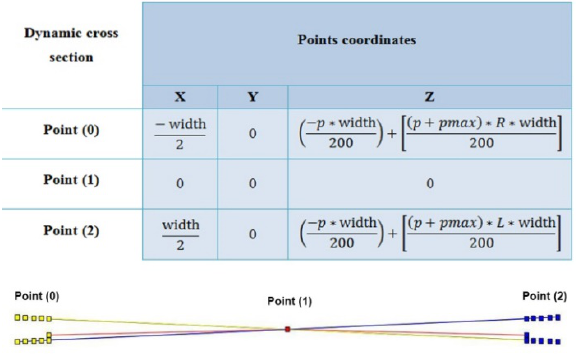
Figure 6. Basic road curves.